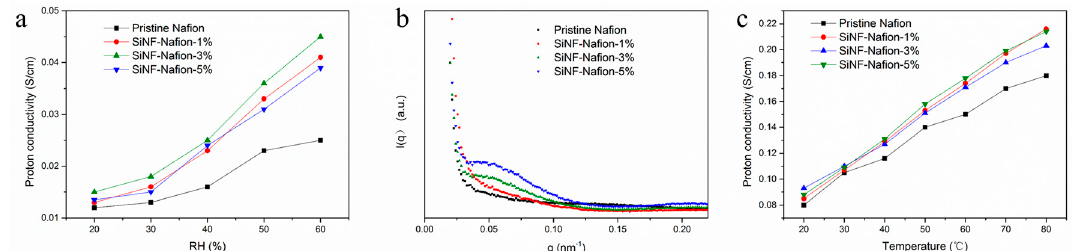
Figure 4. ( a ) High-temperature proton conductivity at low humidity of the pristine Nafion and SiNF-Nafion membranes; ( b ) small-angle X-ray scattering SAXS spectra of the pristine Nafion and SiNF-Nafion membranes; and ( c ) low-temperature proton conductivity at 100% relative humidity of the pristine Nafion and SiNF-Nafion membranes.